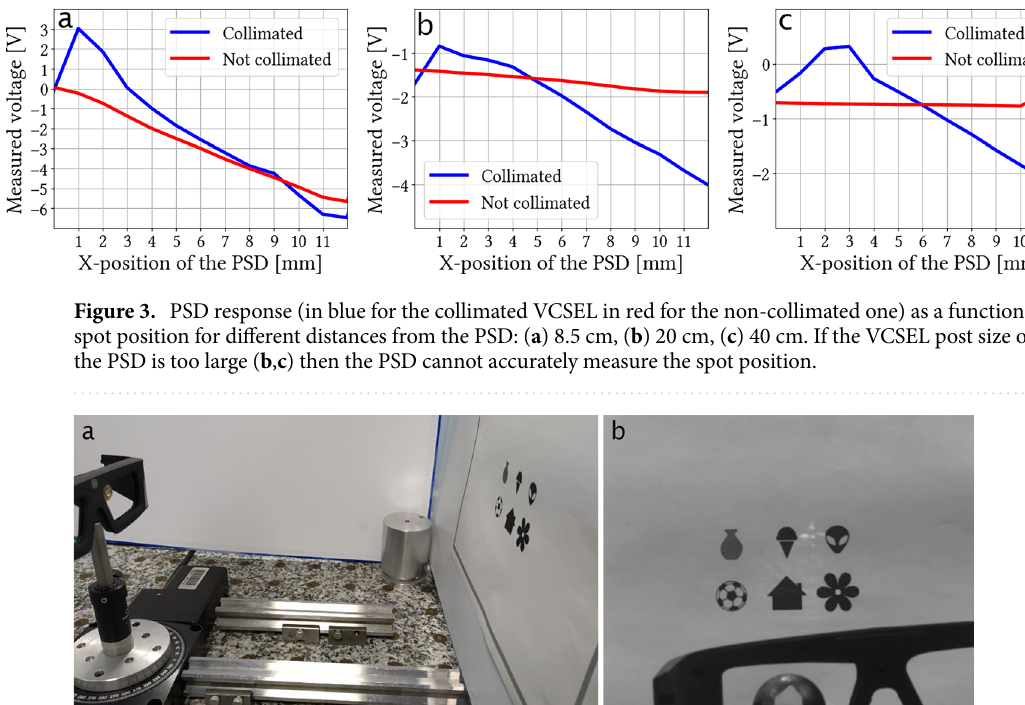
Figure 4. ( a ) Optical set-up used to validate the device. ( b ) The cross projected from the SCL by the laser pointer is clearly visible on the screen when imaged with an infrared